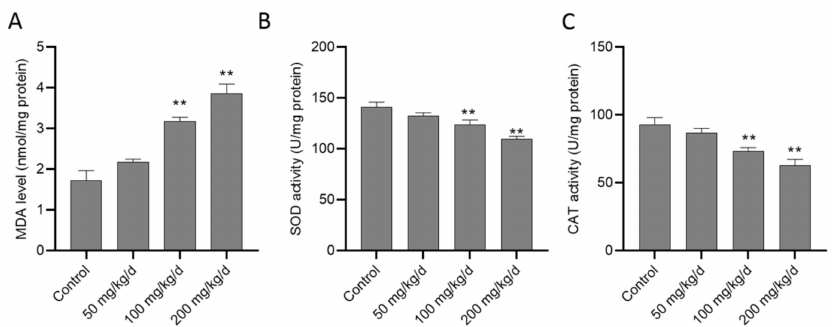
Figure 3. CuSO 4 exposure induces oxidative damage in the kidney tissues of mice. The mice were orally administrated with copper sulfate (CuSO 4 ) at the dose of 50, 100 and 200 mg / kg / day for 28 days, the level of malondialdehyde (MDA) ( A ) and the activities of superoxide dismutase (SOD) ( B ) and catalase (CAT) ( C ) in the kidney tissues were analyzed. Data are presented as mean ± SD ( n = 7). ** p < 0.01, compared to the control